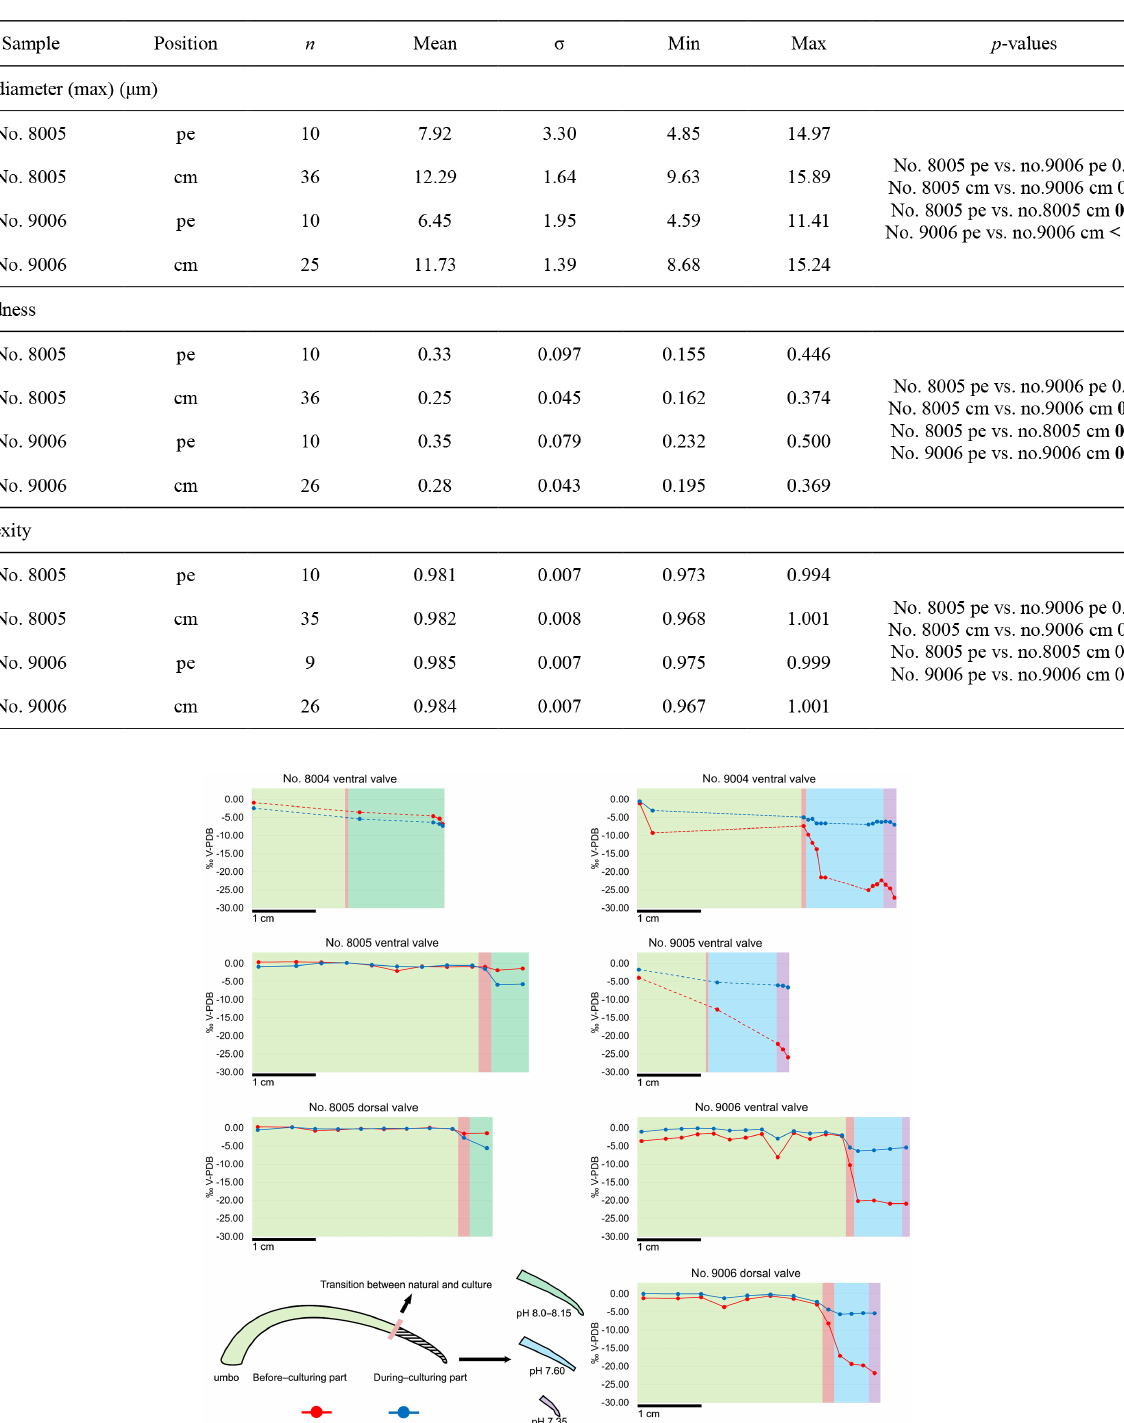
Table 9. Statistical comparison of fibre size and shape data of the posterior external vs. central middle area for no. 8005 and no. 9006,